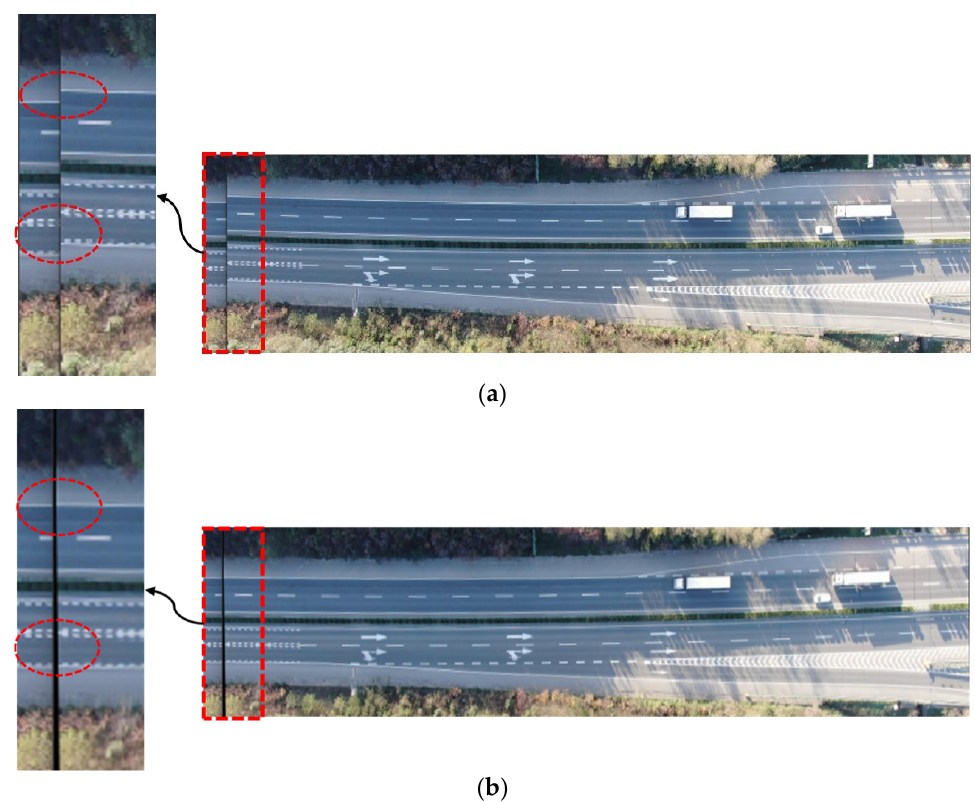
Figure 6. Comparison of different frames ( a ) before and ( b ) after